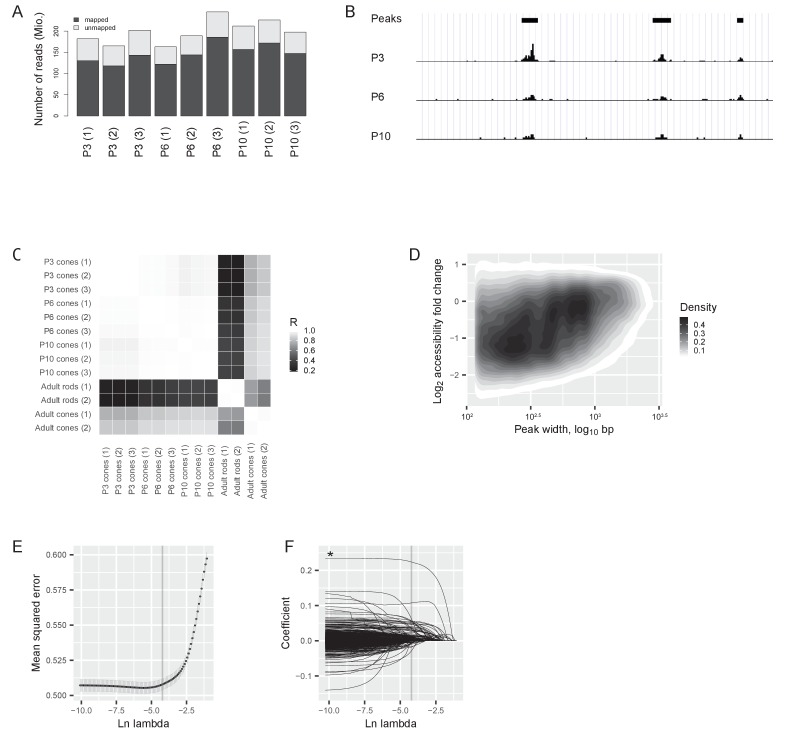
ATACseq quality control and modelling.(A) Total number (in millions) of mapped and unmapped reads for each sample. (B) Example of reads at P3, P6, and P10 at a 27 kb intergenic region on chromosome 1. Identified peaks (using an algorithm from Zhang et al. [Zhang et al., 2008]) are marked with a black bar on the top. The first and second peak (from the left) lose accessibility before the switch (between P3 and P6) by 3- and 2-fold, respectively. They do not change significantly after the switch (between P6 and P10). The third peak’s accessibility changes neither before nor after the switch. (C) ATACseq samples: Pearson correlation between the log2-transformed numbers of reads at each region of accessible chromatin in developing cones compared to adult rods and cones. Data for adult rods and cones are taken from published ATACseq data (Mo et al., 2016), R = Pearson correlation coefficient. (D) Chromatin accessibility changes between P3 and P6 depending on the length of the region (in base pairs (bp), shown as the width of the peaks in panel B). The density of regions of accessible chromatin as a function of peak width and log2 fold change of accessibility is shown. (E) Selection of lambda for the elastic net model by 5-fold cross-validation of lambda values (Materials and methods). Mean cross-validated errors ± s.d. are shown. The grey line shows the highest lambda value at which the mean squared error was within one standard deviation of the minimal error. (F) Model coefficients for each predictor at different values of lambda. The grey line shows the chosen lambda value from (E). The asterisk marks the predictor with the highest coefficient (CTCF binding site).